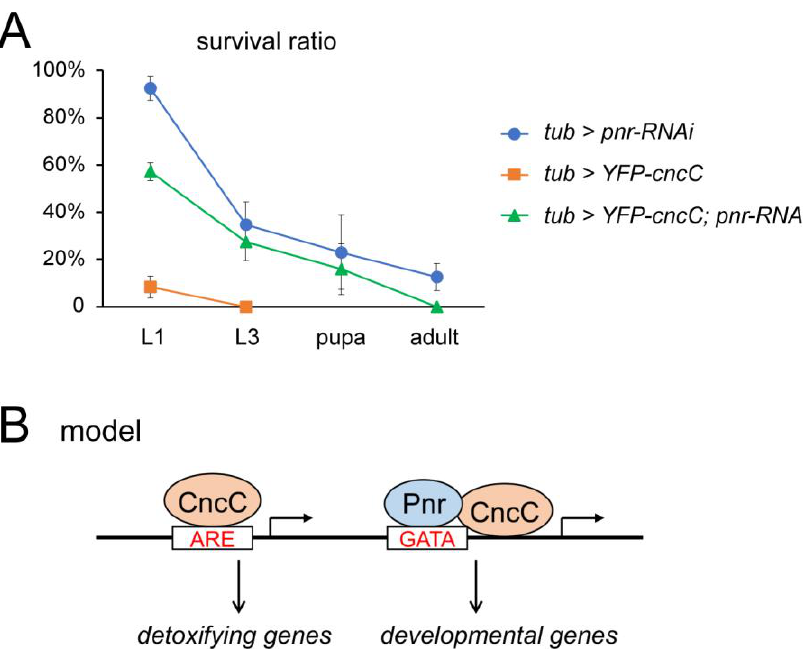
Figure 4. CncC and Pnr function in the same genetic pathway: ( A ) Genetic interaction between cncC and pnr mutants. Numbers of Pnr-knockdown flies ( tub-GAL4/pnr-RNAi ), CncC-overexpressing flies ( UAS-YFP-cncC/+; tub-GAL4/+ ), and the double mutant combining CncC overexpression and Pnr knockdown ( UAS-YFP-cncC/+; tub-GAL4/pnr-RNAi ) were counted at the stages listed below. Survival ratios were calculated by normalization to control flies without tub-GAL4 drivers. The control files were cultured in parallel and identified based on Dfd-YFP and Tb markers on the TM6 balancer. Error bars represent the standard deviation, based on two independent experiments with more than 50 flies counted. ( B ) Model of CncC–Pnr interaction. As a xenobiotic and oxidative response factor, Nrf2/CncC activates detoxifying genes through binding to the ARE element. The CncC–Pnr complex binds to specific chromatin loci and activates developmental genes, indicating a potential novel developmental function of Nrf2 in cooperation with a GATA